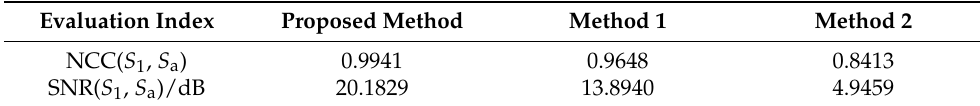
Table 2. Evaluation indexes of denoising effect of the three methods.